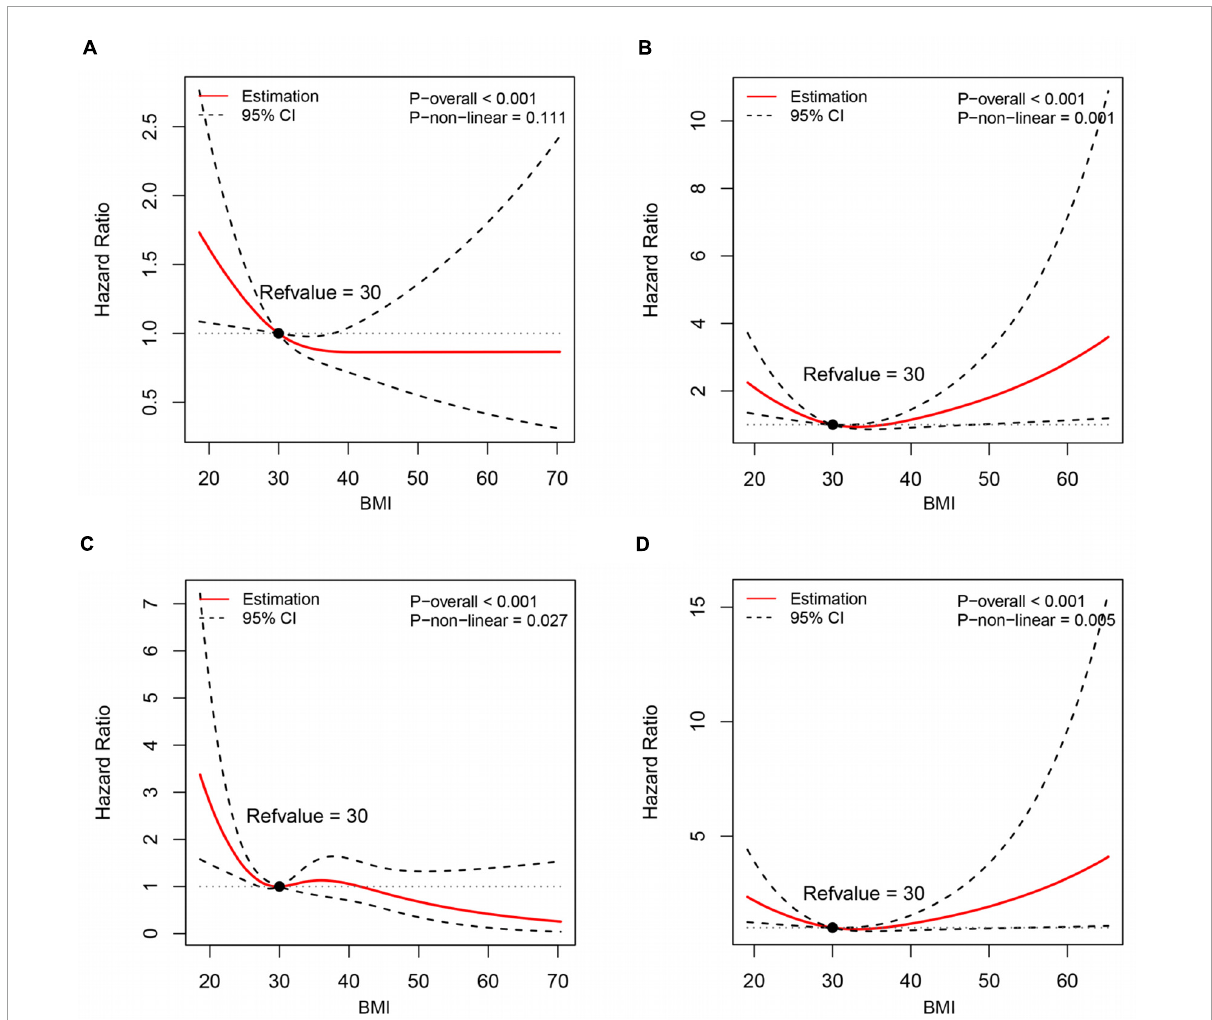
FIGURE3 Association of baseline BMI with long-term all-cause death (A,B) and cardiovascular death (C,D) in HFpEF patients according to HF etiology, using restricted cubic spline models. (A,C) Non-ischemic HFpEF; (B,D) ischemic